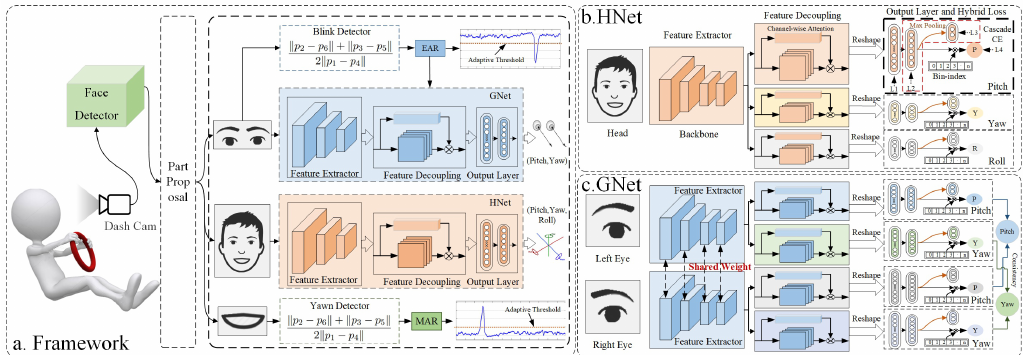
Figure 2. ( a ) The architecture of the proposed appearance-based multi-state driver monitoring system; ( b ) the structure of HNet, which was used for head pose estimation; ( c ) the structure of GNet, which was used for gaze estimation. A demonstration video can be found at https://www.youtube.com/ watch?v=fS4jSiZYGUU, accessed on 22 March